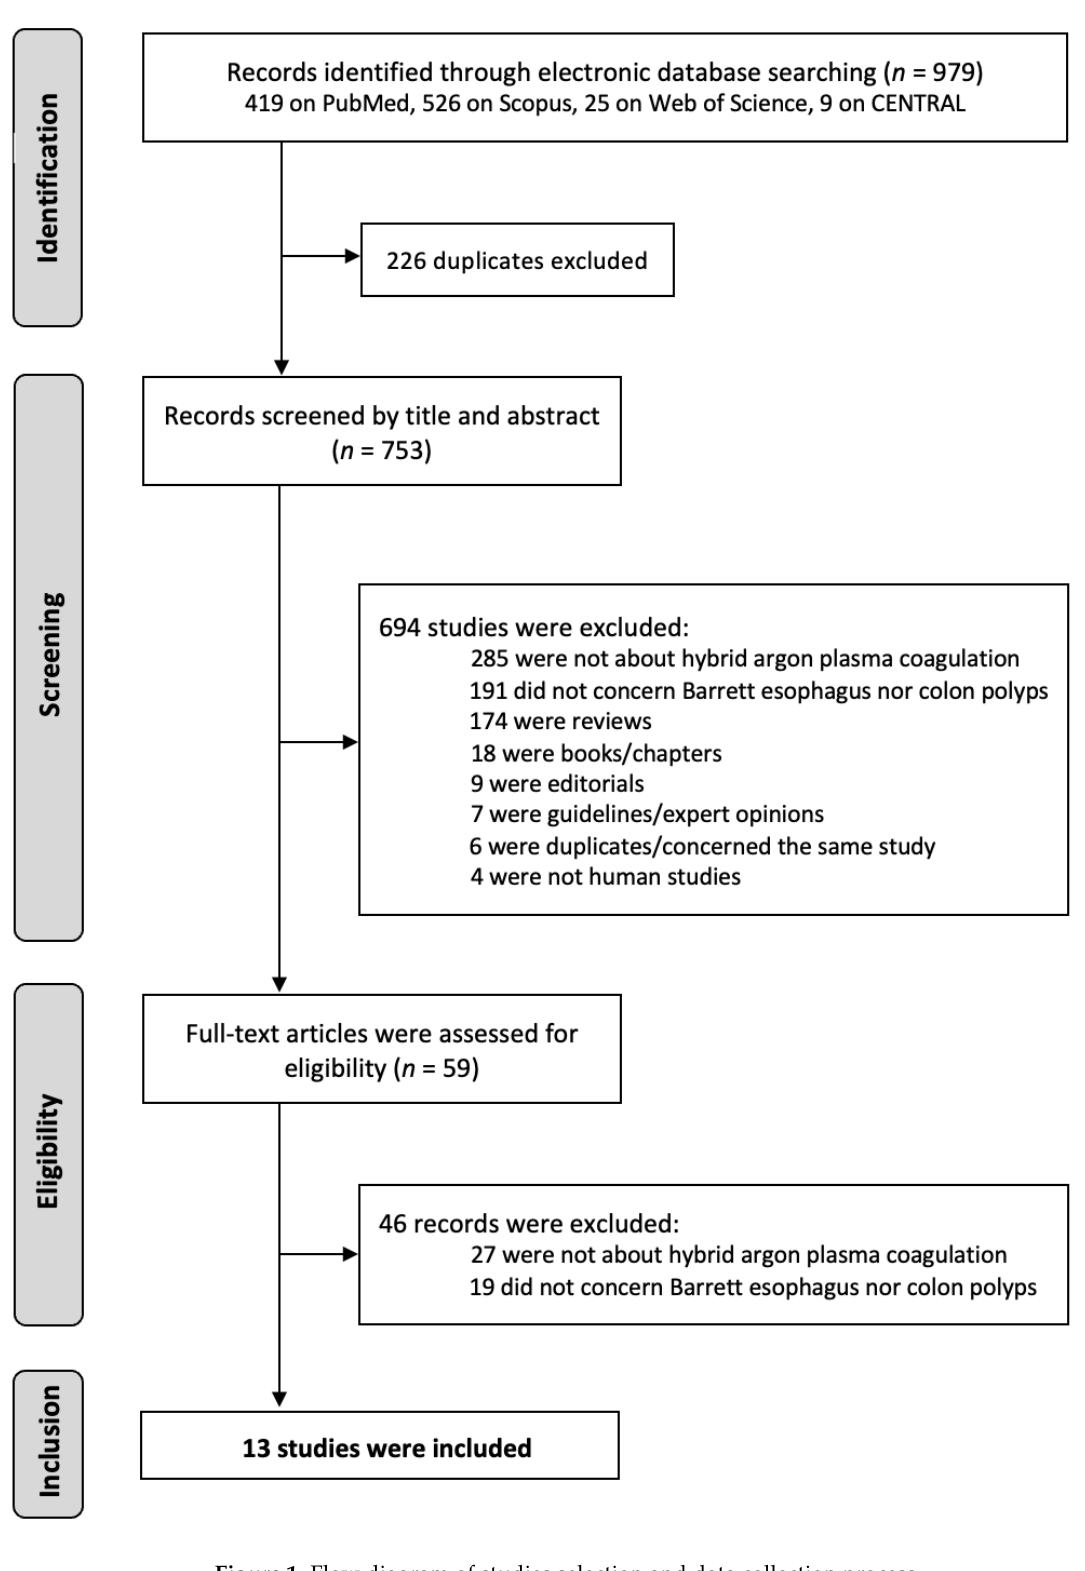
Figure 1. Flow diagram of studies selection and data collection process.